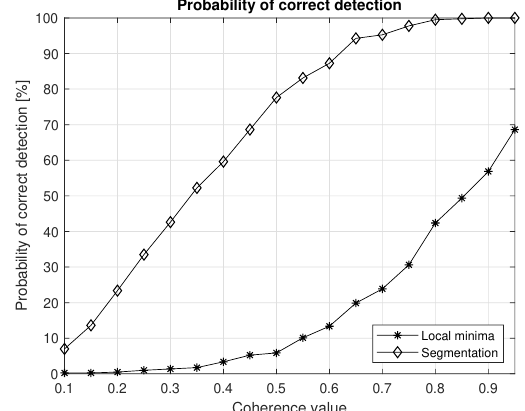
Figure 4: Probability of correct detection for the two sub-optimal algorithms. The M-CCD segmentation approach shows signifi- cantly better performances than the local minima approach.